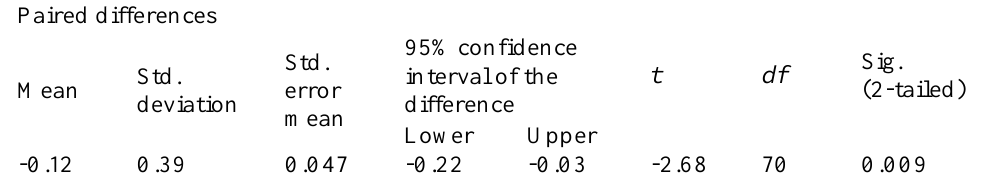
Paired T-Test for Difference in Means between Evaluation Scores Received from Students Participating in the Online Distance Learning Program and the Traditional Classroom Program